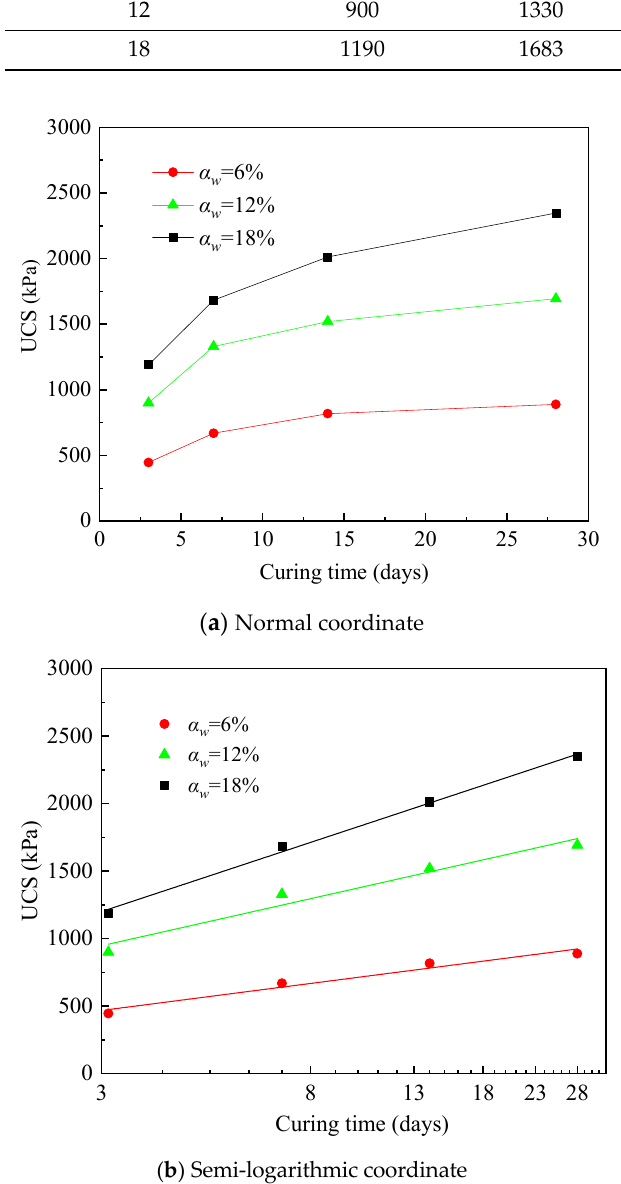
Figure 7. Correlation between UCS and curing time .